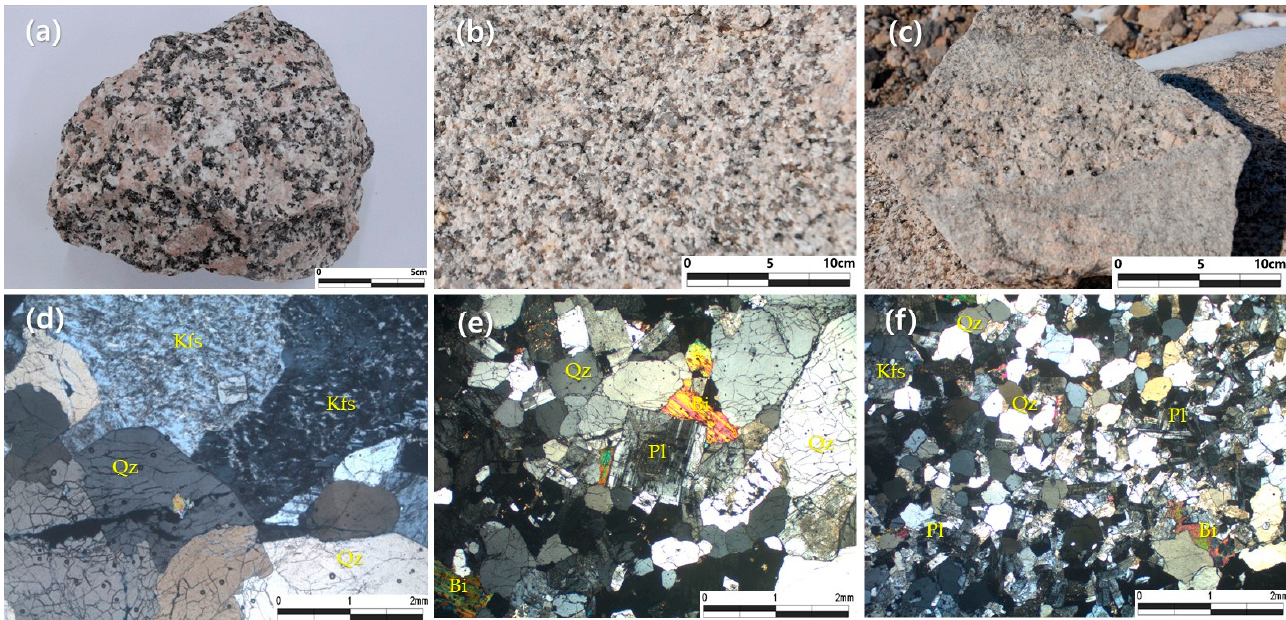
Figure 2. Representative field photographs and photomicrographs (crossed polars) of the Pirrit Hills granite. ( a ) Coarse- grained two mica granite (P008). ( b ) The homogeneous medium-grained granite. ( c ) Aplite vein. ( d ) Coarse-grained two mica granite (P008). ( e ) Medium-grained two mica granite (P005-1). ( f ) Fine-grained two mica granite (P005-2).